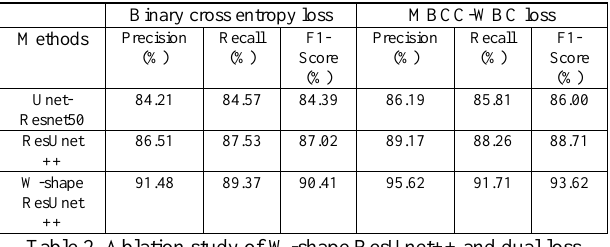
Table 2. Ablation study of W-shape ResUnet++ and dual loss based on MBCC-WBCE loss on BCDD validation